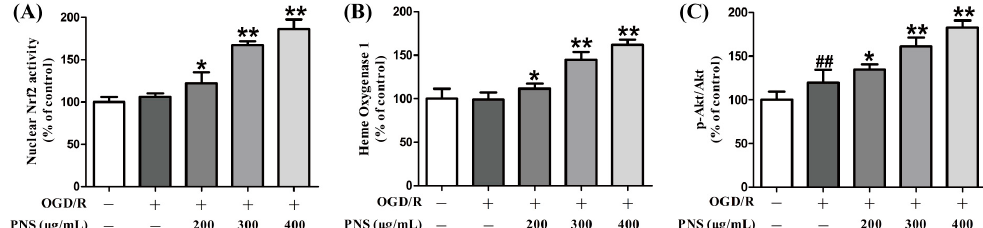
Figure 5. Effects of PNS on the upregulation of the expression of Akt-Nrf2 pathway relative proteins in bEnd.3 cells after OGD4h/R12h challenge. ( A ) A transcription factor assay kit was used to determine the activity of nuclear Nrf2 which binds to a specific dsDNA sequence containing the Nrf2 response antioxidant response element in the wells. ELISA assays to determine the HO-1 expression ( B ) and p-Akt/Akt ratio ( C ) in bEnd.3 cells after OGD/R and PNS treatment. Data are expressed as mean ± SD (N = 6). ## p < 0.01 vs. Control, * p < 0.05 and ** p < 0.01 vs. Model.